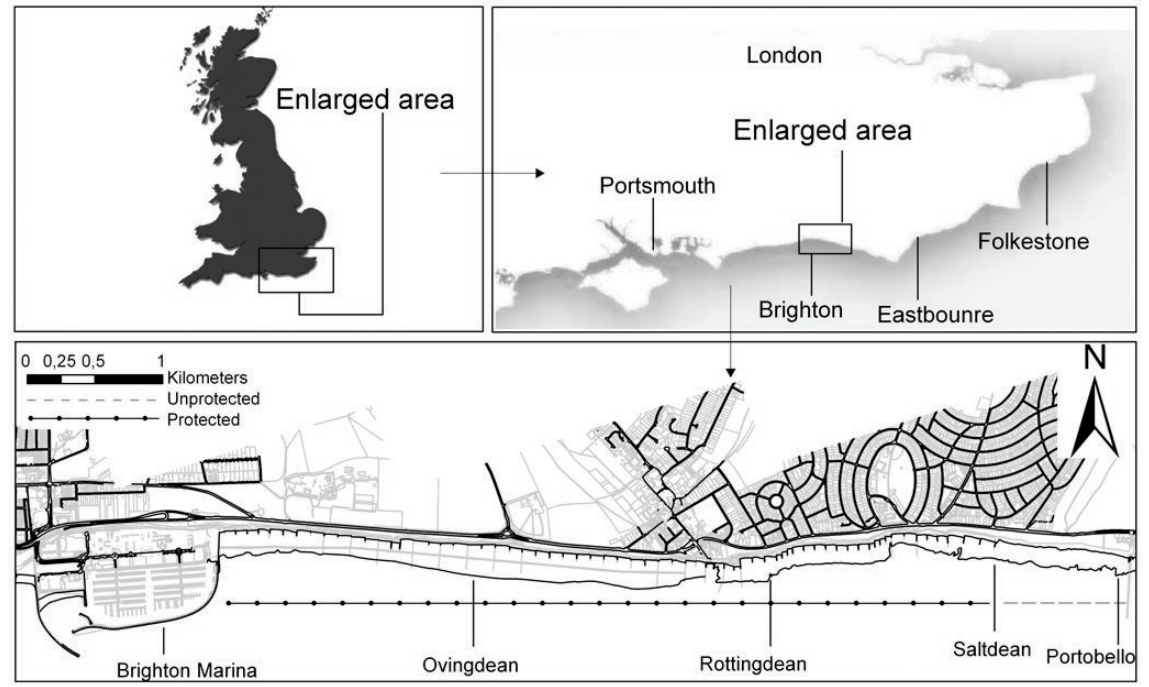
Fig. 1. Location of the study